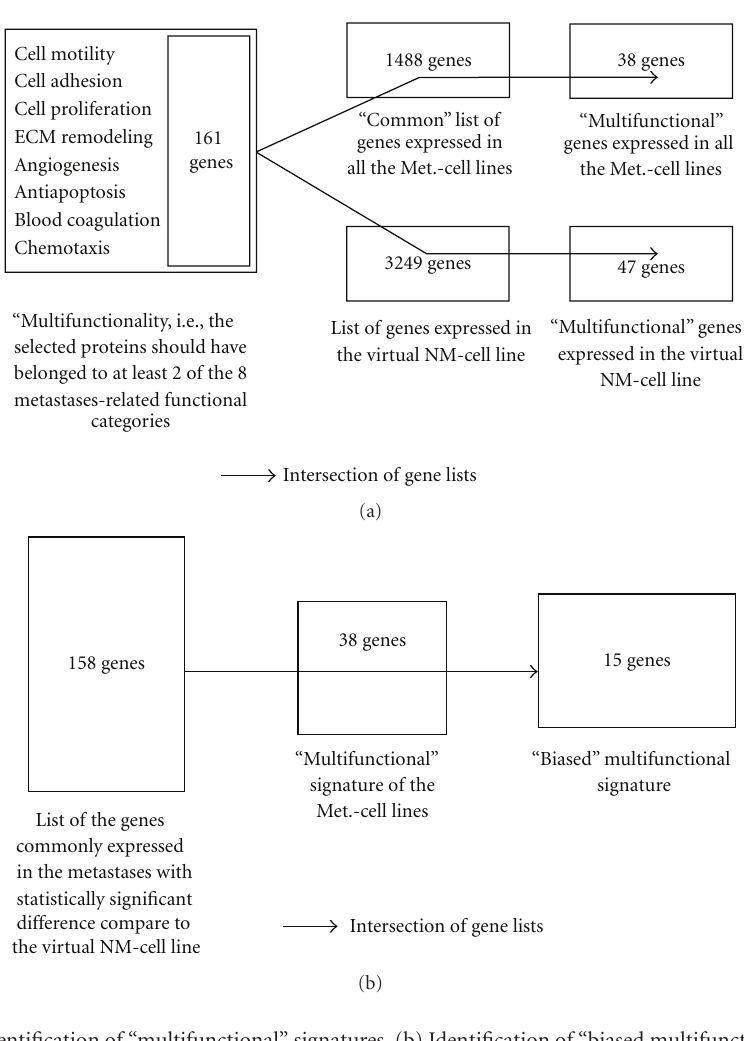
Figure 3: (a) Identification of “multifunctional” signatures. (b) Identification of “biased multifunctional”